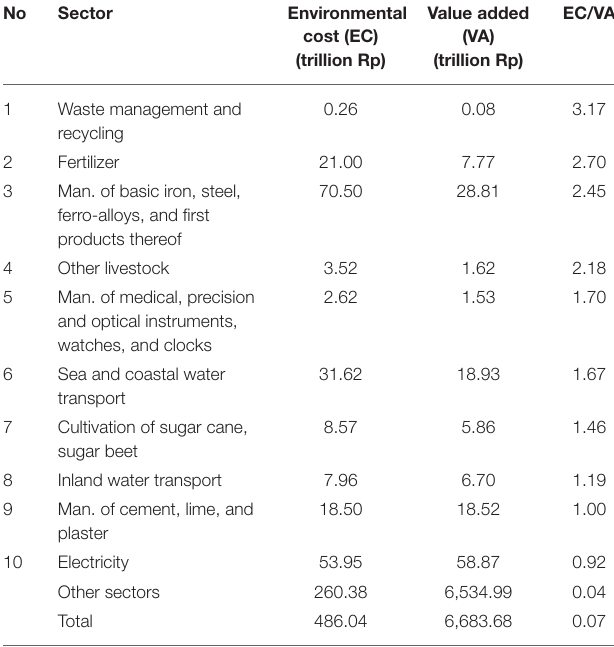
TABLE 7 | Top 10 ratio of total environmental cost compared to value added. TABLE 8 | Classification of sectors in the Indonesian economy, 2010, in terms of the potential of environmental costs